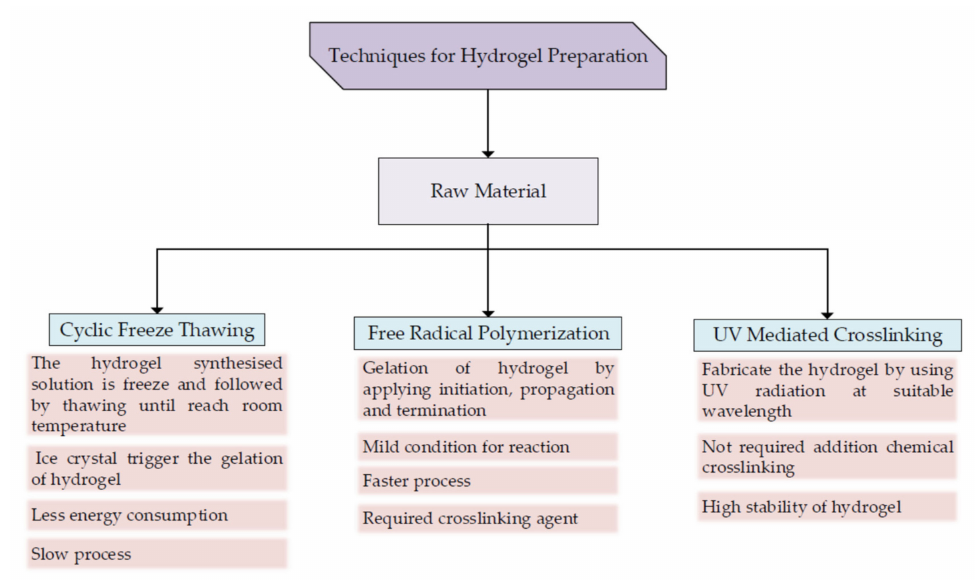
Figure 7. Few techniques for hydrogel